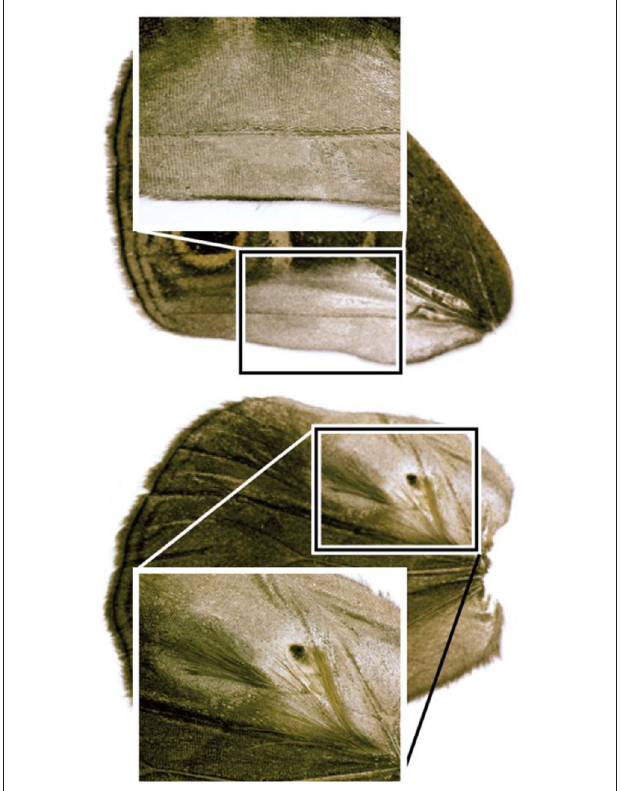
FIGURE 1 | Male ventral forewing containing sex scales (top) and dorsal hindwing containing both sex scales and androconia